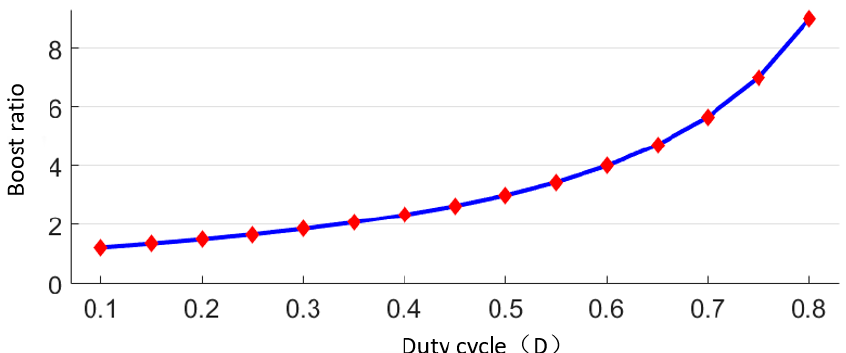
Figure 4. Relationship between the boost ratio of a dual-switch boost converter and duty cycle of MOSFET switch.